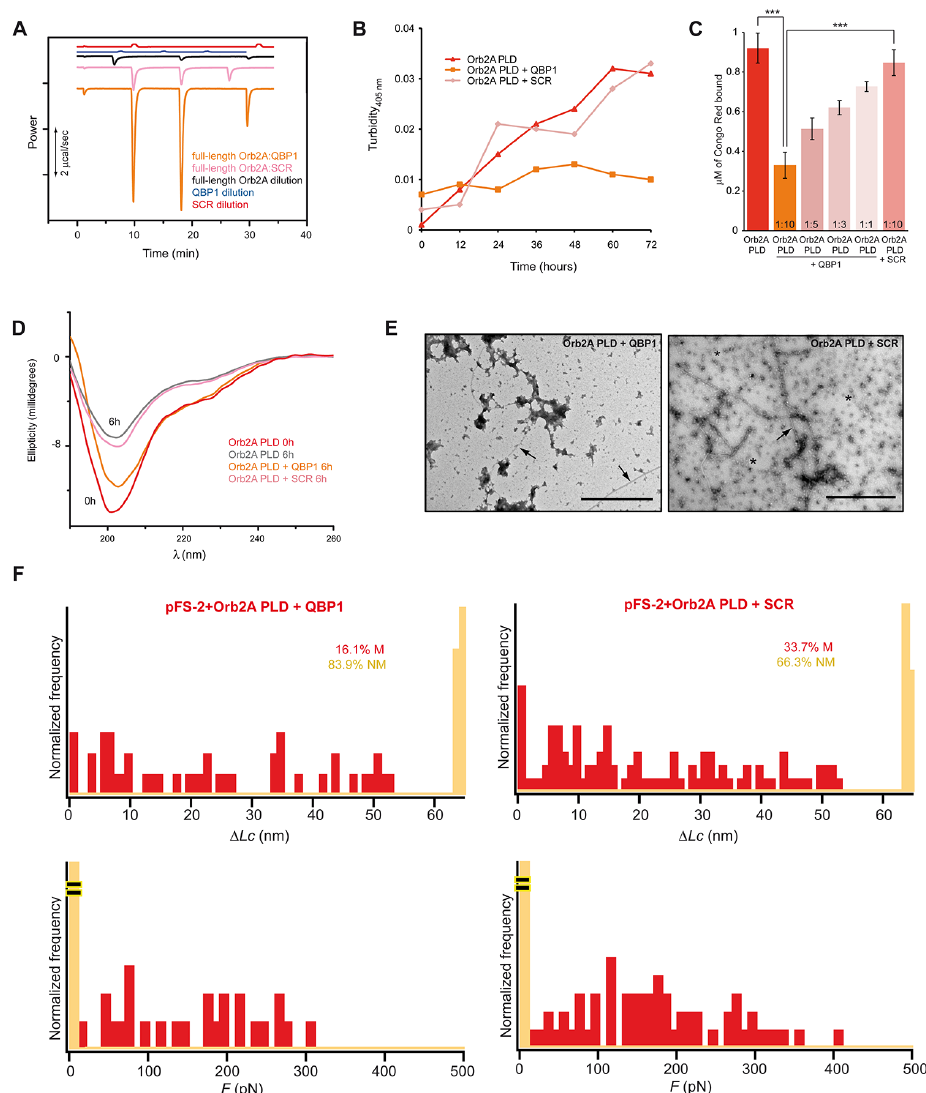
Fig 6. QBP1 interferes with Orb2 amyloid formation in vitro. (A) Representative calorimetric traces for the interaction of full-length Orb2A with the QBP1 and SCR peptides. Traces in orange and pink correspond to the heat released upon injection of Orb2A into the ITC cell loaded with an excess of QBP1 or SCR, respectively, while black, blue, and red traces correspond to the Orb2A, QBP1, and SCR dilutions, respectively. (B) QBP1 but not SCR drastically reduced the turbidity at 405 nm of aged Orb2A PLD. (C) QBP1 reduces the quantity of amyloid formed as shown by measuring the CR bound to Orb2A PLD. The data are represented as the mean ± SEM: * p < 0.05 and *** p < 0.001 (One-way ANOVA and Tukey post-test). (D) Far-UV CD spectroscopy in the absence or presence of QBP1 or SCR indicates that QBP1 blocks protein precipitation over time of Orb2A PLD, but SCR does not. (E) Representative electron micrographs show that oligomers (asterisks) and amyloid fibers (arrows) of Orb2A PLD were drastically reduced when incubated with QBP1 (left) but not with the SCR (right). Scale bars: 1 μ m. (F) The conformational polymorphism of Orb2A PLD is strongly diminished in the presence of a 1:10 molar excess of QBP1, which decreases the M frequency relative to the NM conformers (QBP1, n = 112 and SCR, n = 101). The underlying data for panels in this figure can be found in S1